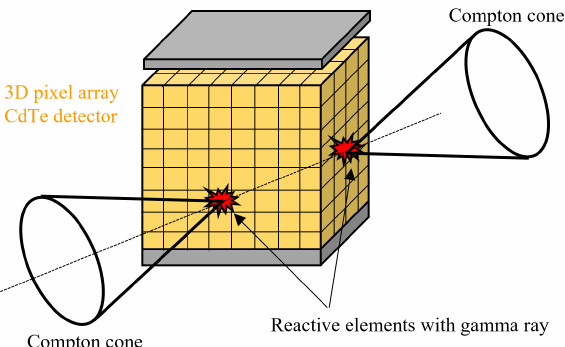
Figure 4. Obtaining Compton cones using an all-around view Compton camera: the all-around view Compton camera projects Compton cones on both sides of a straight line connecting the two interacting